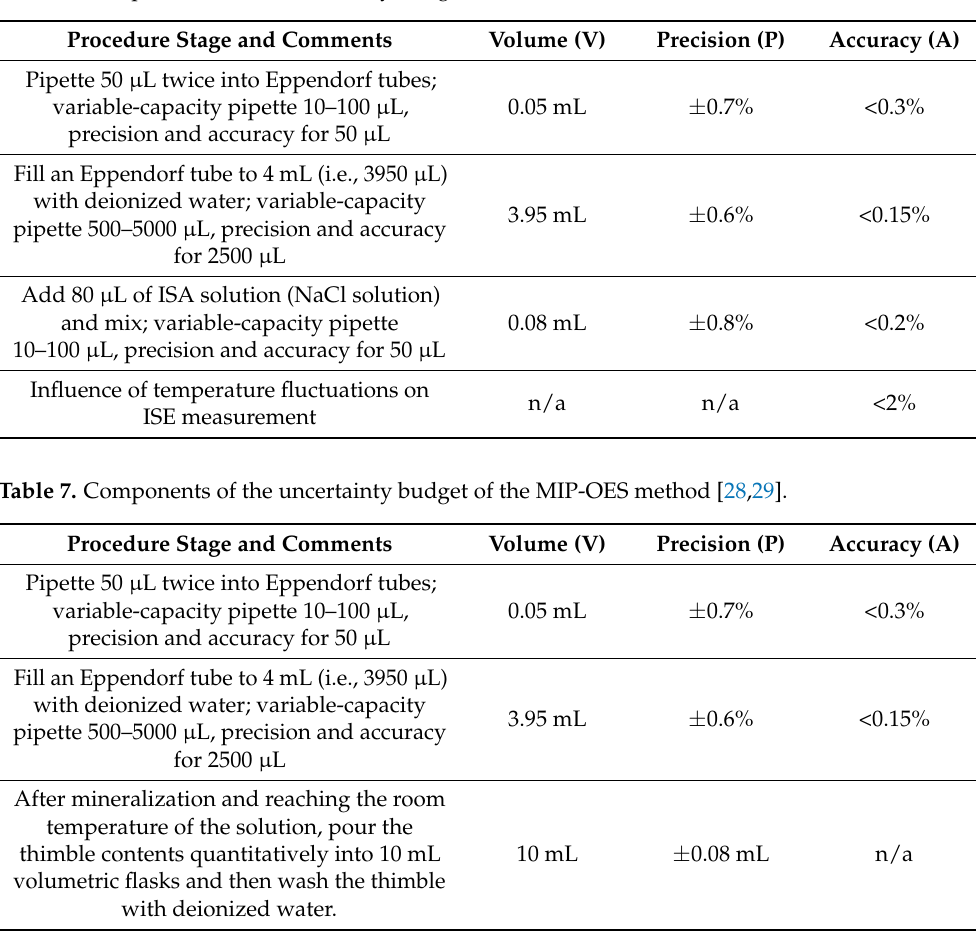
Table 6. Components of the uncertainty budget of the ISE method [28,29].